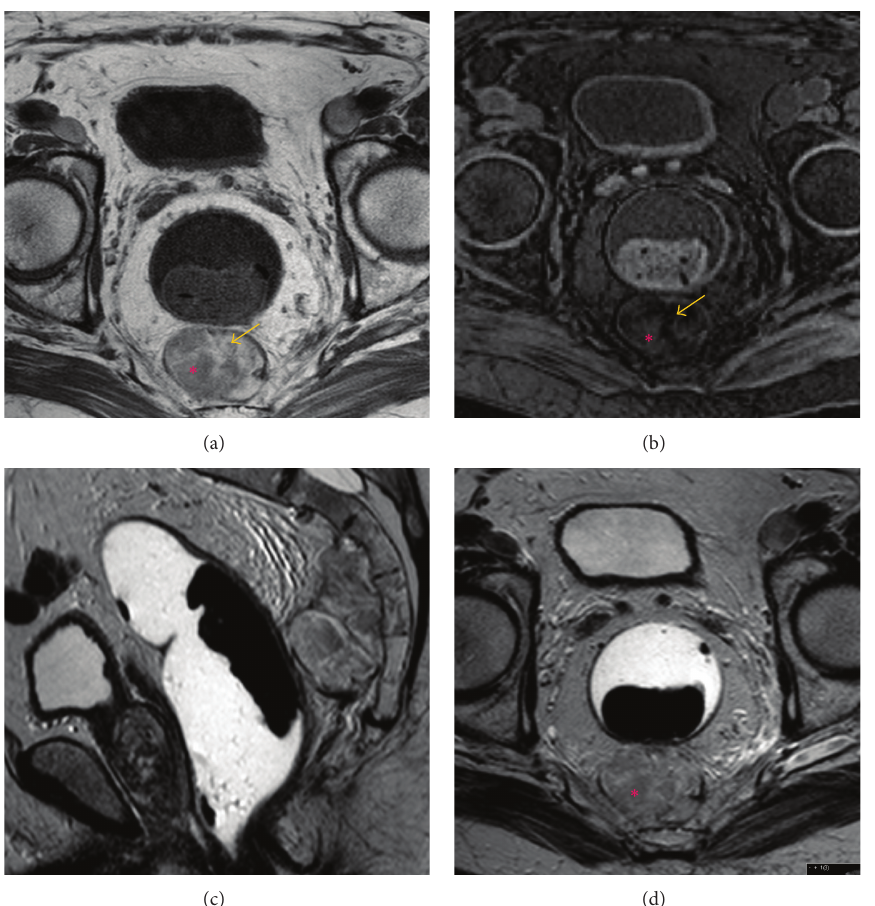
Figure 2: 84-year-old male with presacral myelolipoma. Precontrast T1-weighted (a) and fat-suppressed T1-weighted (b) FSE axial images depicted the presence of macroscopic fat (arrows). The solid hematopoietic elements (asterisk) exhibited intermediate signal on precontrast T2-weighted sagittal (c) and axial (d) images and low-signal intensity on T1-weighted